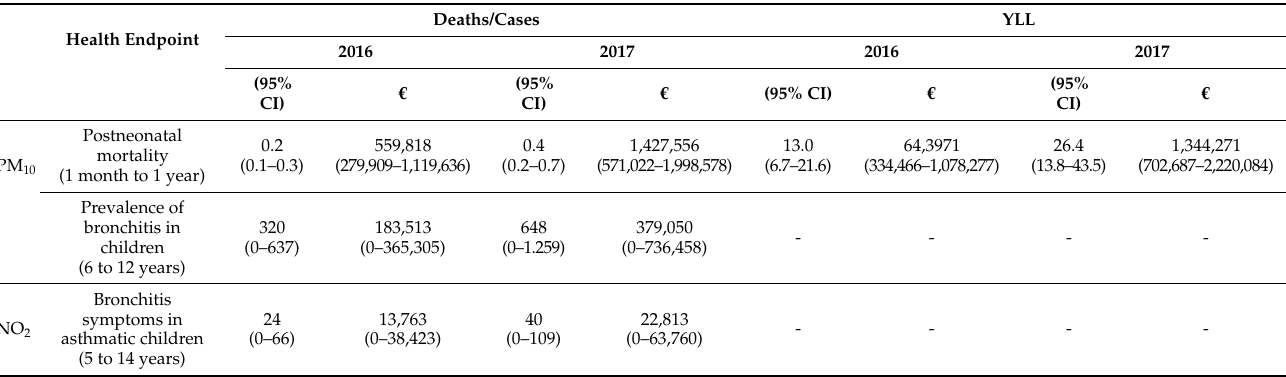
Figure 2. Spatial distribution of annual mean concentrations of PM 10 in the study domain for 2016 and 2017, considering (F-SCN) and not considering (B-SCN) wildland fire emissions. Concentrations are in µ g m − 3 . The burnt area is represented in red. Table 4. Estimated attributable cases, years of lost life (YLL) and related costs, due to wildland fires, occurred during 2016 and